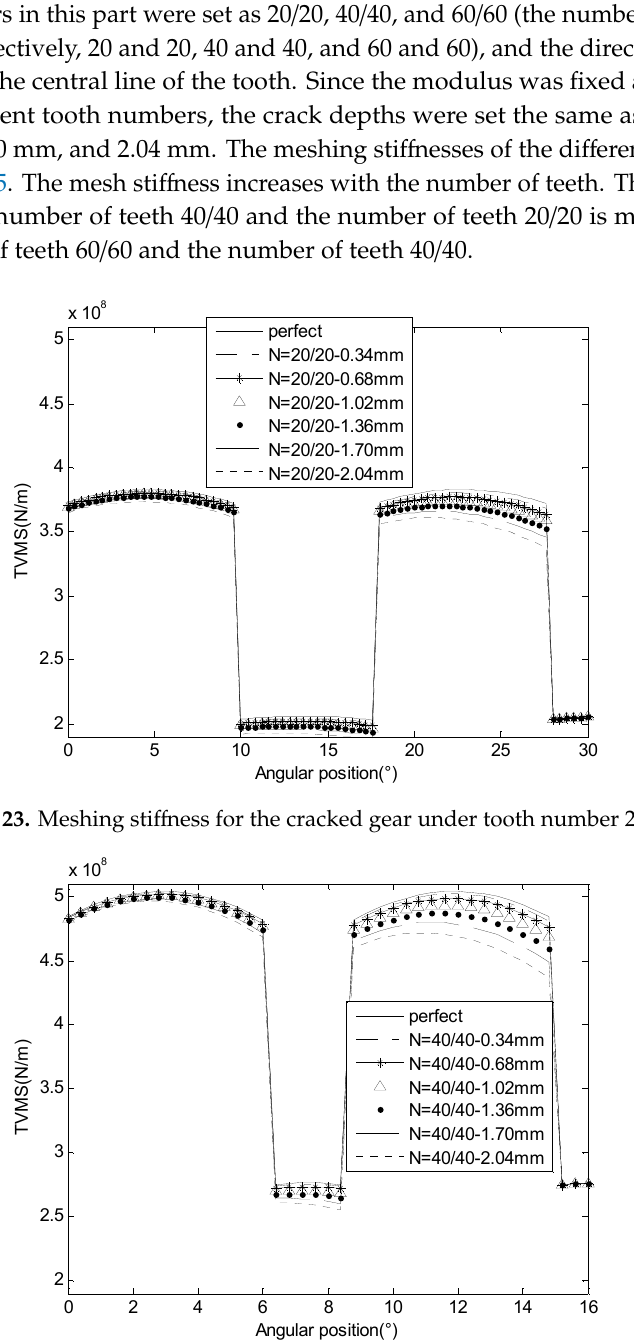
Figure 24. Meshing stiffness for the cracked gear under tooth number 40/40